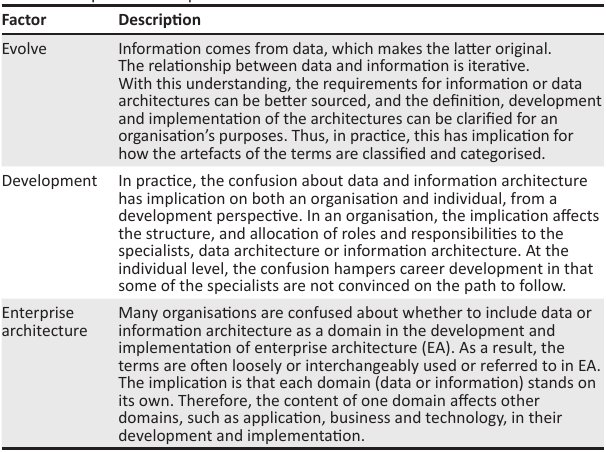
TABLE 3: Implications of